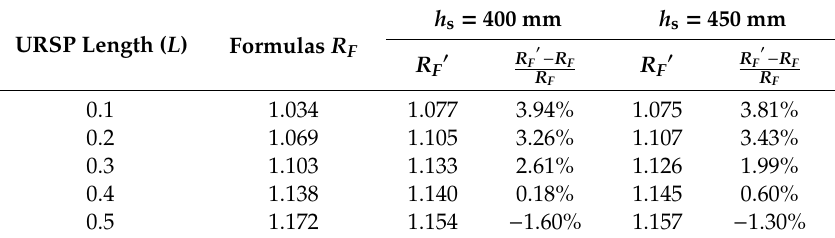
Table 4. R F of middle joints under load case